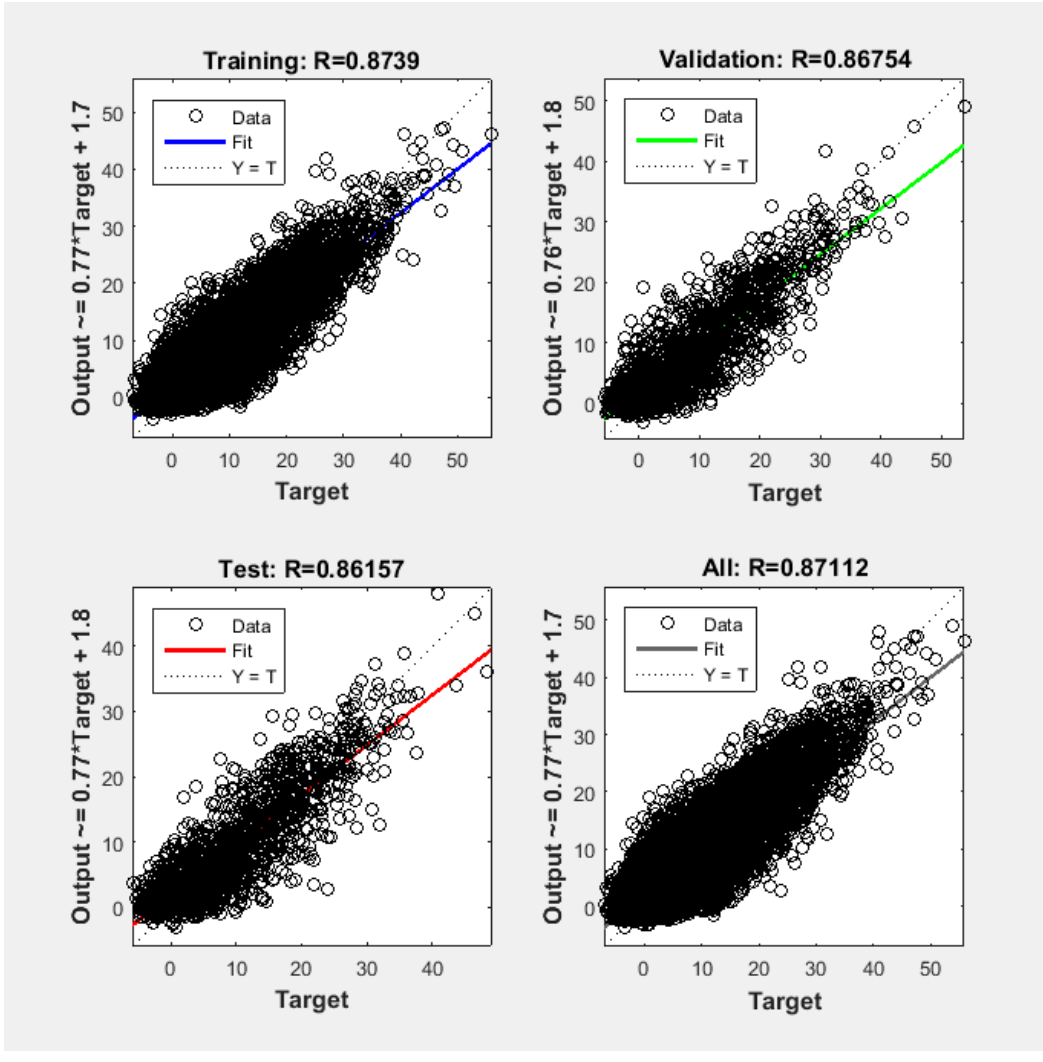
Figure 9. Machine Learning (ML) model accuracy.